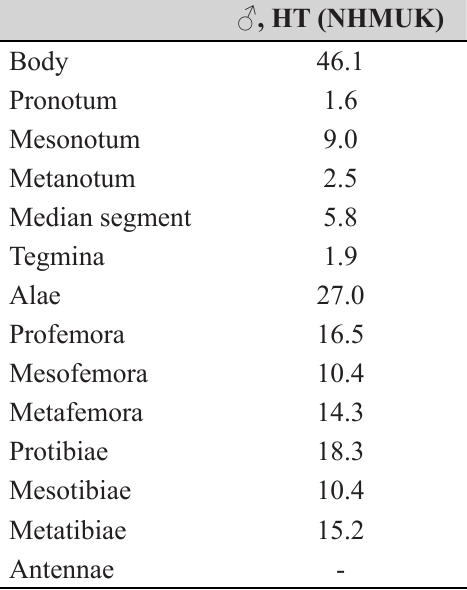
Table 10 . Measurements of Phantasca puppeius (Westwood, 1859) (in mm). HT =